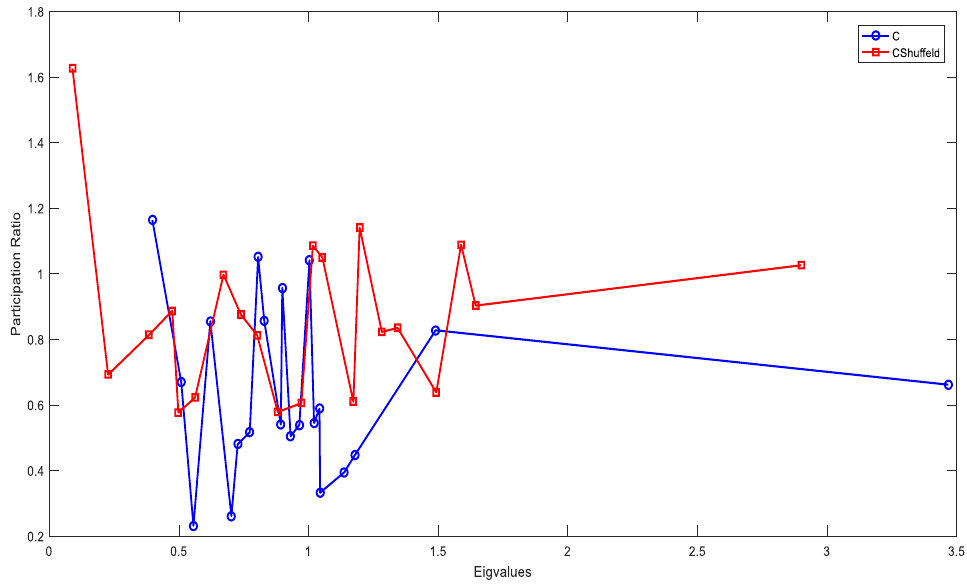
Figure 5. Comparison of for the correlation matrix and shuffled one. Whatever the difference between them is lower, the collective behavior of the market is